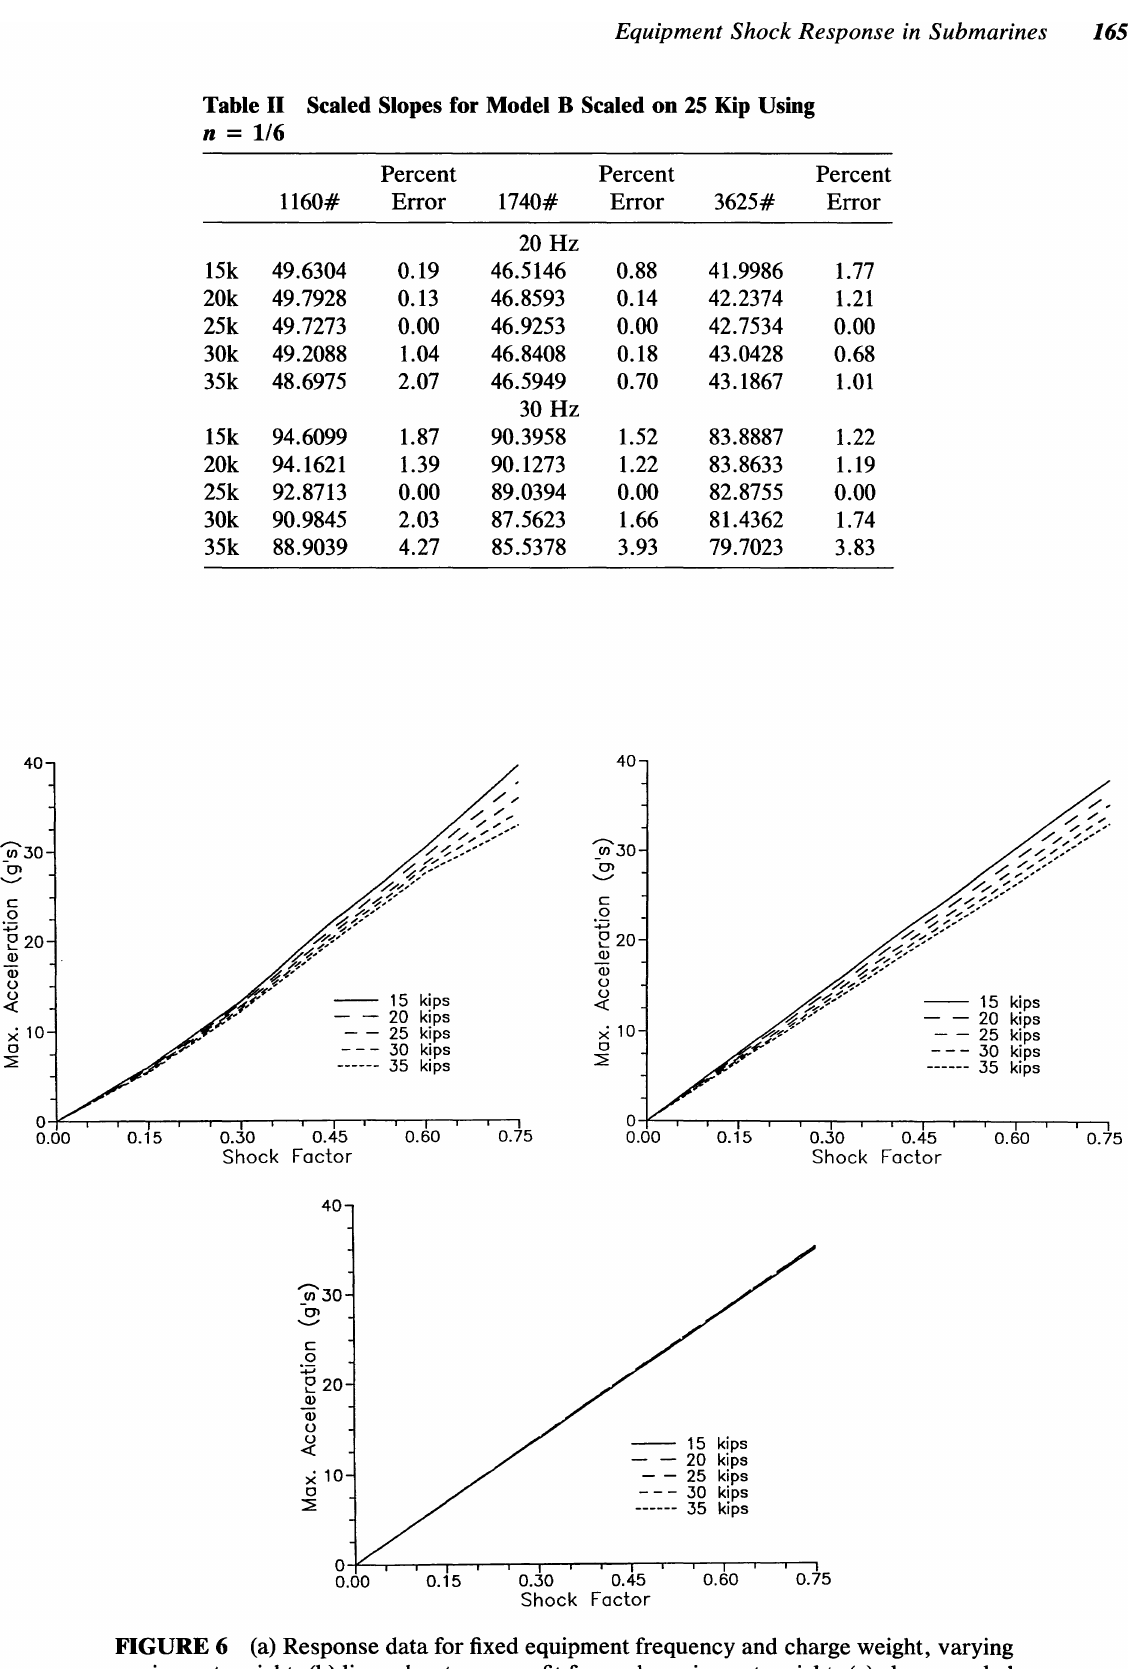
FIGURE 6 (a) Response data for fixed equipment frequency and charge weight, varying equipment weight; (b) linear least squares fit for each equipment weight; (c) slopes scaled to the 25-kip equipment